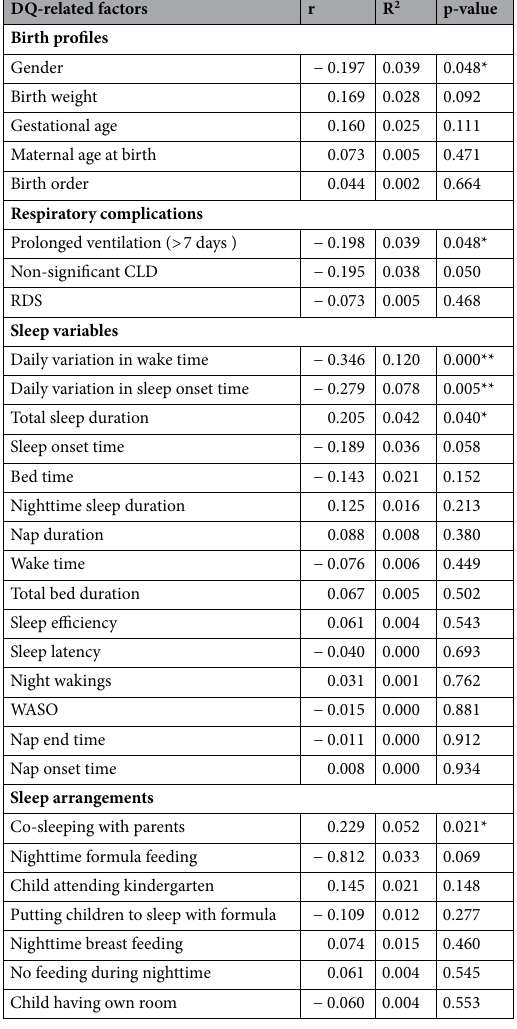
Table 4. The associations of birth profiles, respiratory complications, sleep variables, and sleep arrangements and DQ scores evaluated by univariate regression analysis (**p < 0.01, *p < 0.05). RDS respiratory distress syndrome, Non-significant CLD non-significant chronic lung